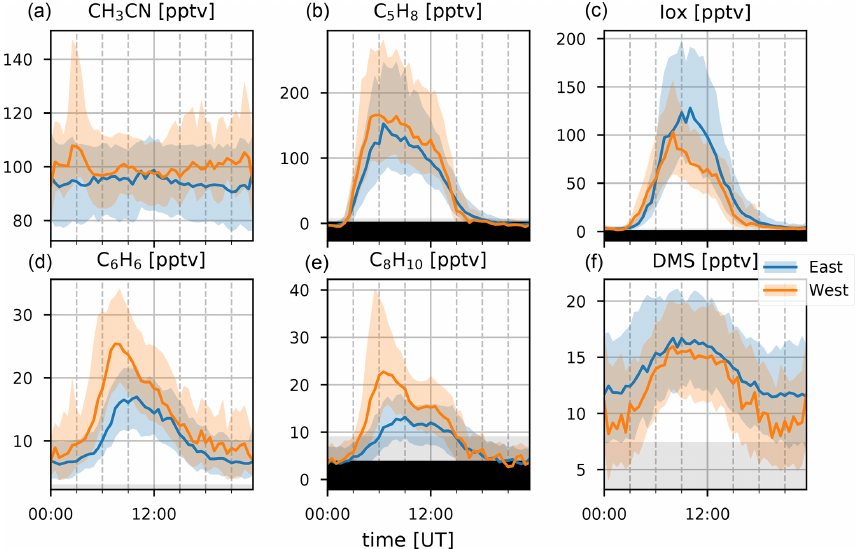
Figure 4. Median diel profiles (lines) and the interquartile distance (shaded area) for CH 3 CN, C 5 H 8 , Iox, C 6 H 6 , C 8 H 10 , and DMS (a–f) separated between easterly (blue) and westerly (orange) transport recorded at the observatory. Gray background shows the range between the median limit of detection and the minimum limit of detection of half-hour measurements. Individual half-hour measurements in the black region of the plots are not quantifiable.